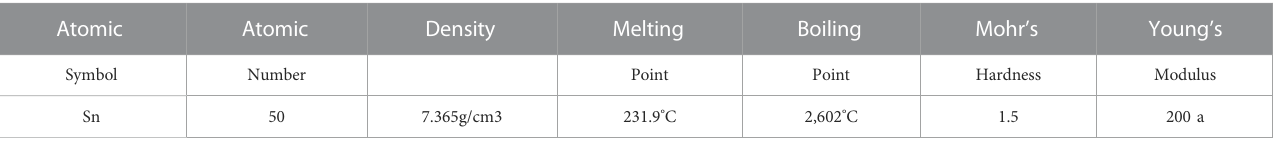
TABLE 1 Properties of